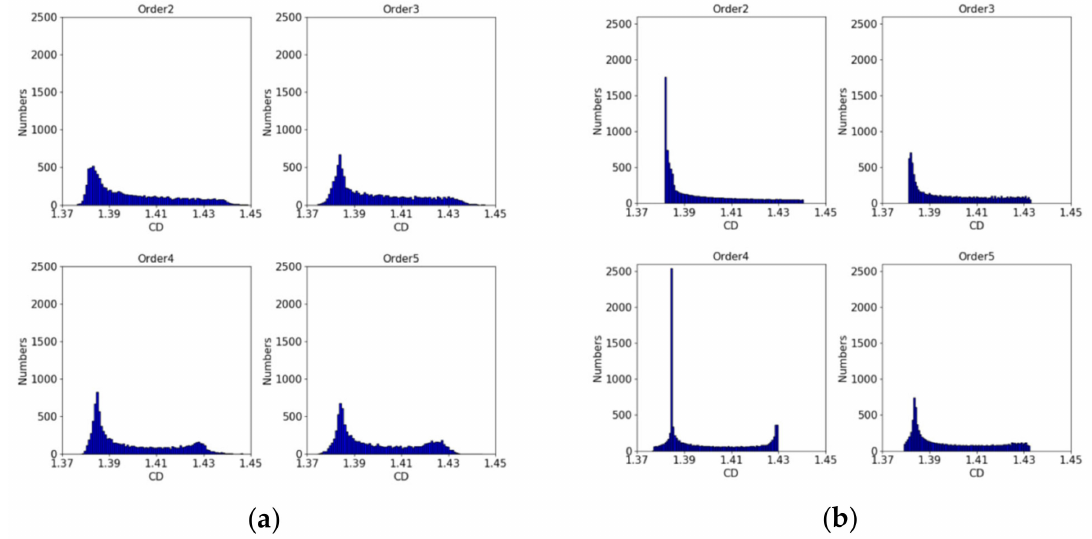
Figure 10. PDF analysis of the lift coefficient (CL): ( a ) point-collocation non-intrusive polynomial; and ( b ) non-intrusive spectral